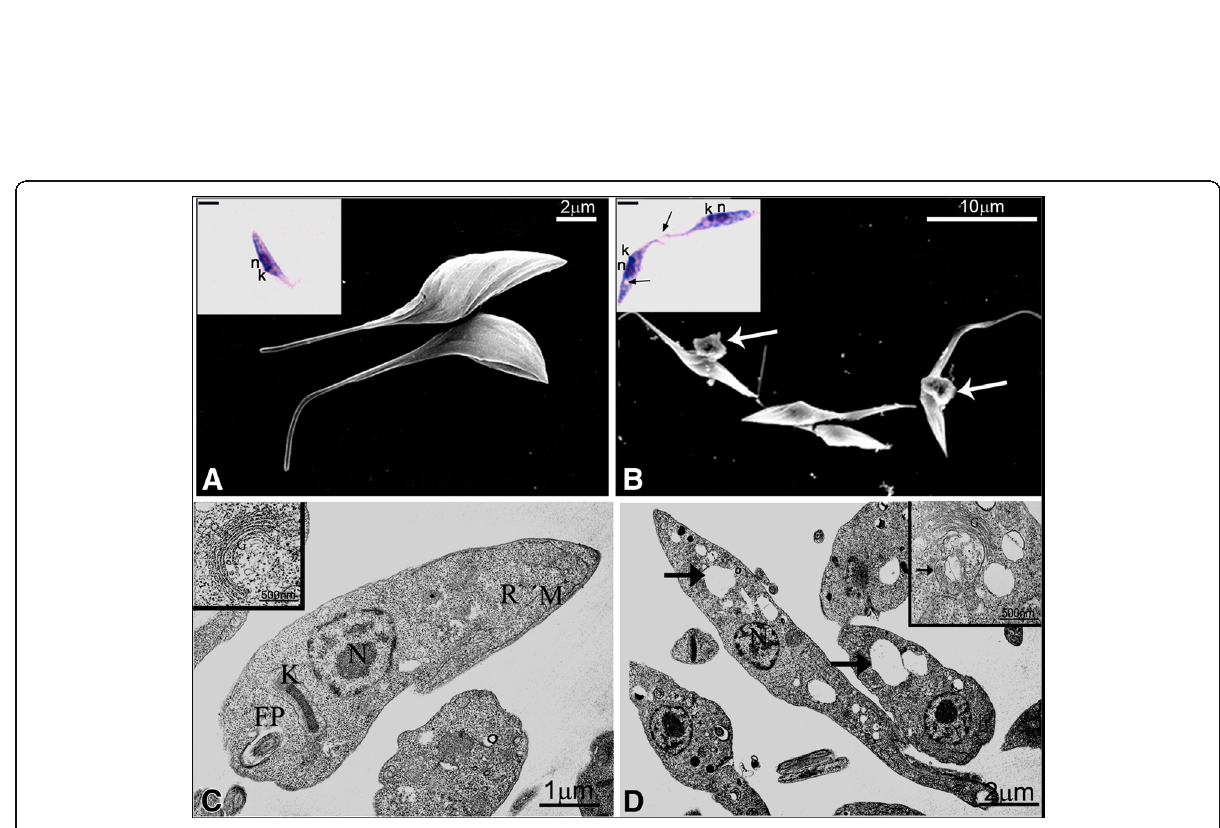
Fig. 3 Morphological alterations of Trypanosoma cruzi epimastigotes treated with IC 50 /48 h 2-BP. a - b Scanning electron microscopy of control ( a ) and 2-BP-treated ( b ) parasites. Note the extracellular leakage at the flagellar pocket region of treated epimastigotes (write arrows). Insets (bar=5 μ m): bright field microscopy of Giemsa-stained parasites. Control parasite (in a ) showing the characteristic elongated shape; treated parasites (in b ) were larger, with large vacuoles and were adhered by their flagella (black arrows). c - d Transmission electron microscopy. Control epimastigote ( c ) showing the typical elongated morphology. A representative Golgi complex is shown in the inset. 2-BP-treated parasites ( d ) presented large electron lucent vacuoles at the anterior tip (black arrows) and Golgi complex alterations (arrow in inset). N: nucleus; K: kinetoplast; FP: flagellar pocket; G: Golgi complex; R: reservosome; M: mitochondrion. Bars =5 μ m